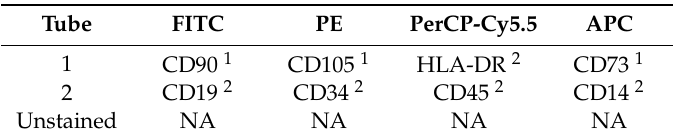
Table 3. MoAbs fluorochrome conjugated employed for surface staining to characterize hMSCs: fluorescein isothiocyanate (FITC); phycoerythrin (PE); peridinin chlorophyll protein-cyanine5.5 (PerCP-Cy5.5); allophycocyanin (APC). Tube FITC PE PerCP-Cy5.5 APC 1 CD90 1 CD105 1 HLA-DR 2 CD73 1 2 CD19 2 CD34 2 CD45 2 CD14 2 Unstained NA NA